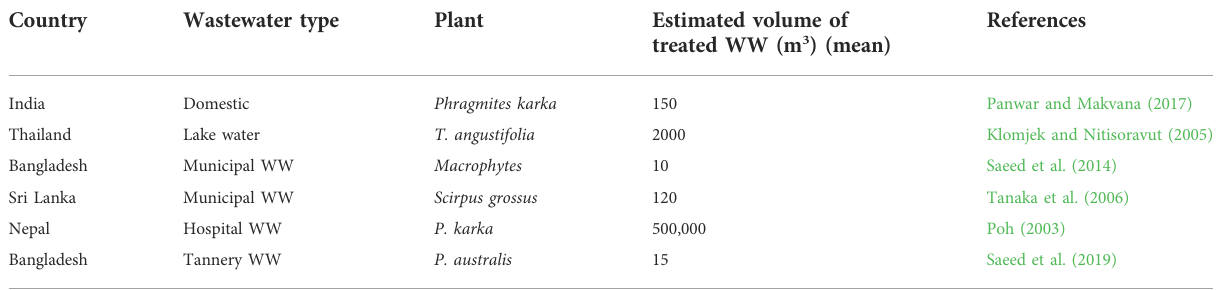
TABLE 7 Estimated volume of treated wastewater in different developing countries.